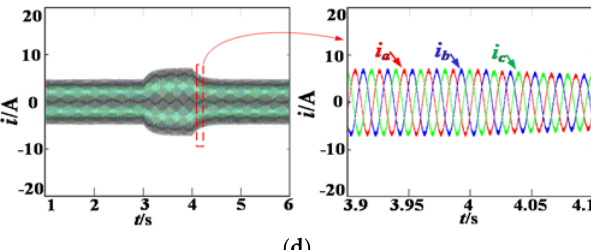
Figure 8. Frequency ‐ variation influence on parameters when wind speed is constant. ( a ) Wind speed, torque, turbine speed and DC ‐ link voltage; ( b ) generator ‐ side three ‐ phase current, current local magnification; ( c ) frequency, active and reactive power; ( d ) grid ‐ side three ‐ phase current, current local magnification.